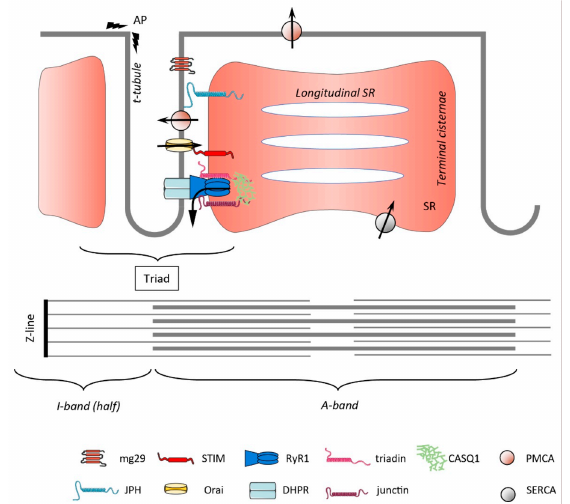
Figure 1. Schematic representation of the main components of the triad and the contractile ap- paratus. The thick and thin lines represent the myosin and actin filaments, respectively. AP — action potential, mg29 —mitsugumin 29, JPH —junctophilin, RyR1 —ryanodine receptor 1, DHPR — dihydropyridine receptor, CASQ1 —calsequestrin 1, PMCA —plasma membrane Ca 2+ ATPase, SERCA —sarco-endoplasmic reticulum Ca 2+